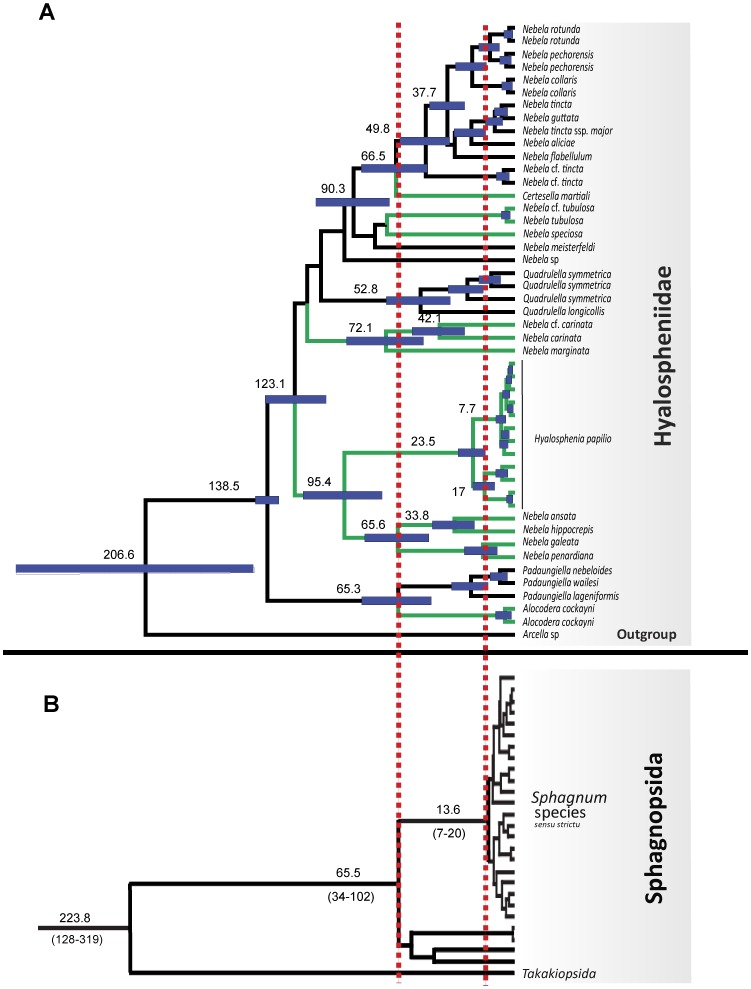
Maximum credibility tree of Hyalospheniidae obtained from COI dataset analyses.A. Reconstructed ages and 95% Highest Posterior Density (HPD; indicated with horizontal blue bars) were retrieved using BEAST [34] with only one COI sequences per GMYC lineage (i.e. evolutionarily independent unit). Arcellinid lineages occurring only in Sphagnum dominated peatlands are marked with green lines. Lineages that occur in Sphagnum dominated peatlands and/or other habitats are marked with black lines. Numbers on nodes correspond to divergence times in million years. Taxonomic assignment is indicated on the right. B. Sphagnum chronogram from eight mitochondrial, plastid, and nuclear genes. Dates (±standard errors) from Shaw and colleagues [16]. Red dotted vertical lines indicate early split of the Sphagnopsida (65.5 Myr ago) and radiation of ca. 300 spp of Sphagnum (13.6 Myr ago).